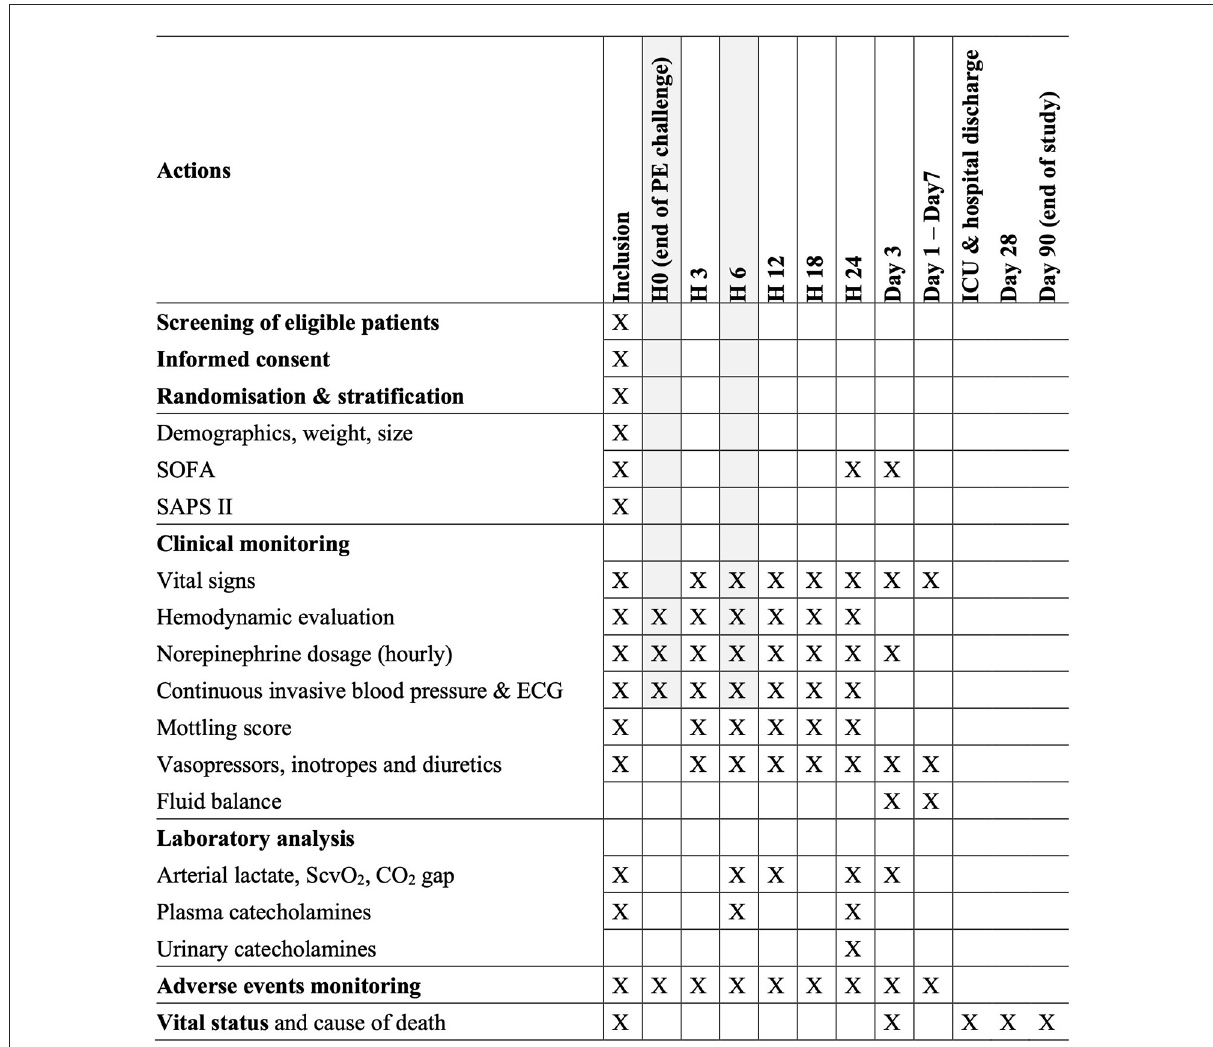
FIGURE2 Flowchart of study procedures. * In the absence of a functioning pacemaker. LVEF, left ventricle ejection